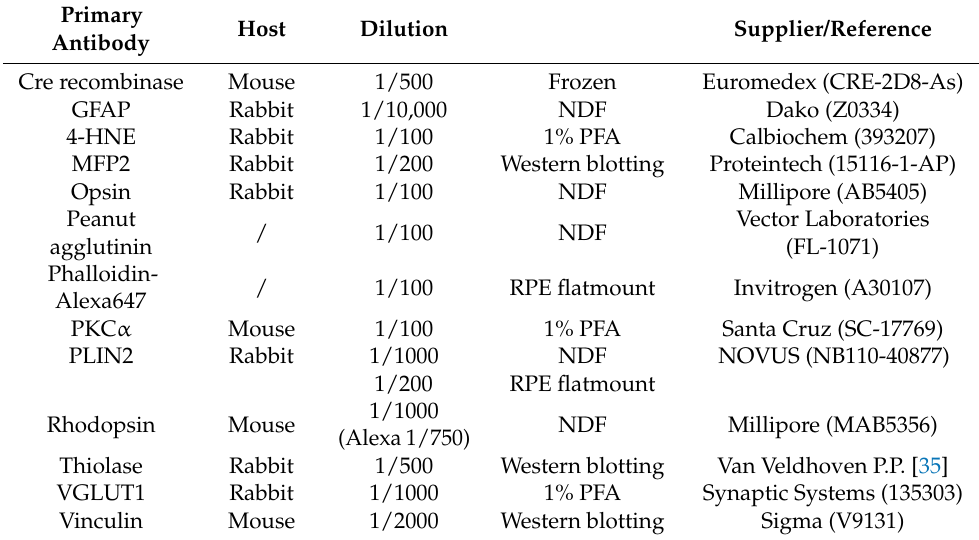
Table 2. List of used antibodies for immunohistochemical staining and Western